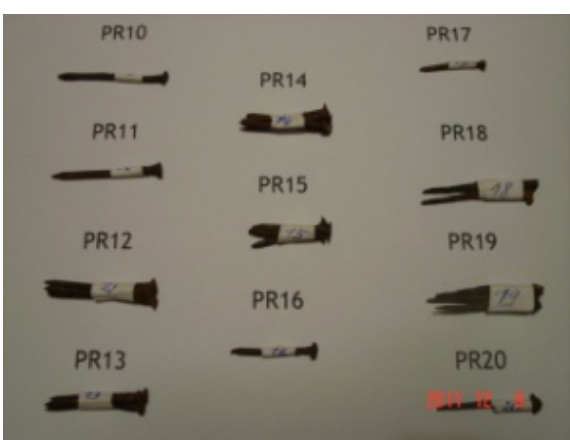
Figure 4: Nails sample collected.